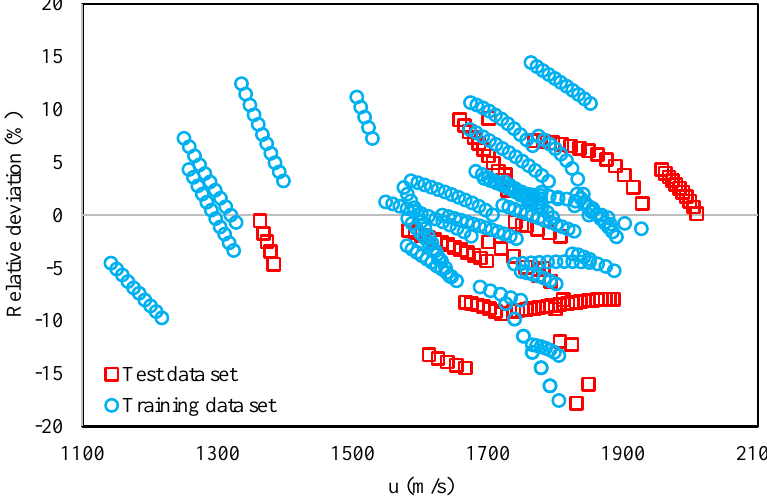
Figure 2. The relative deviation percent for the entire investigated data range for both the training and test datasets.